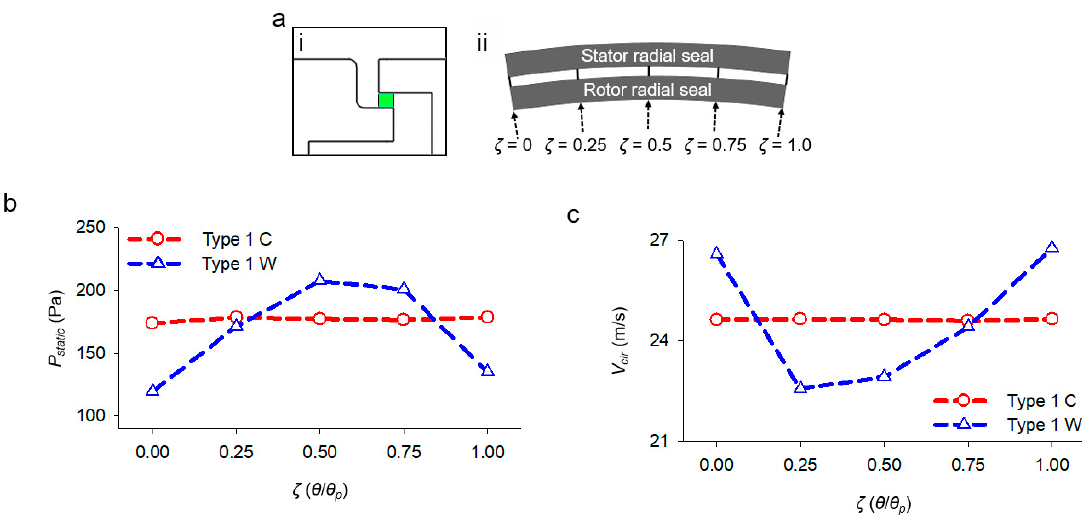
Figure 8. Numerical results of static pressure and circumferential velocity in the radial seal region. ( a ) Measuring plane position; ( b ) Static pressure distribution; ( c ) Circumferential velocity distribution.